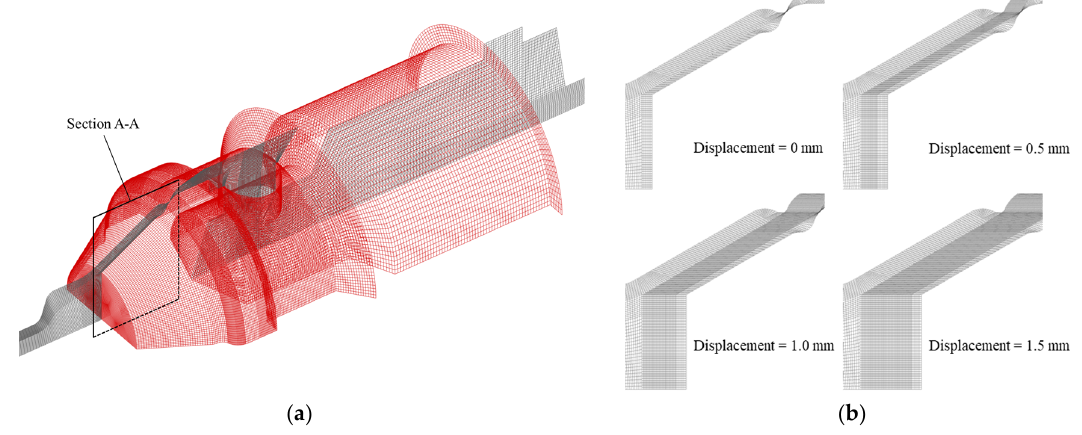
Figure 9. Initial and updated meshes for the chosen mesh: ( a ) Initial meshes of the valve spool and symmetrical plane; ( b ) Updated meshes of section A-A during the transient.